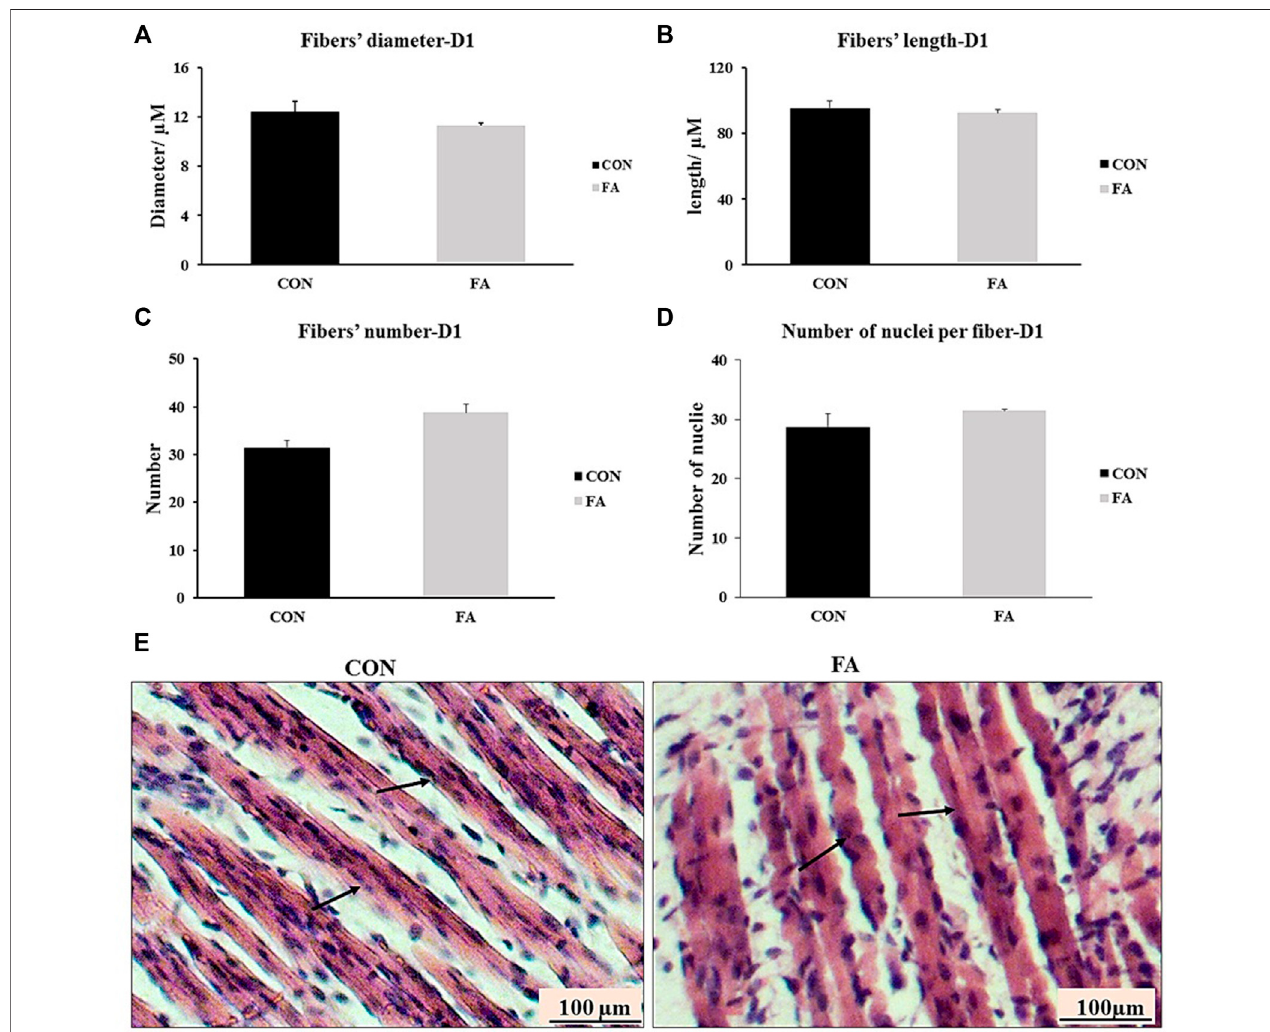
FIGURE 4| Effect of maternal intake ofEPA/DHA on myotubes formation in day 1 neonates. The mothers were fed either control diet (CON) or EPA/DHA enriched diet(FA)duringtheentireperiodofpregnancyandlactation. (A) Datashowsthedifferenceinthediameterofmuscle fi bersmeasuredinmicrometerbetweenCONandFA groups. (B) Data shows the difference in the length of muscle fi bers measured in micrometer between CON and FA groups. (C) The difference in the number of muscle fi bers inthe cross-sectionsbetweenCONand FA groups. Images wereanalyzed inImageJ-FIJI using the Freehand SelectionTool to encircle individual myo fi bers. (D) The difference in the number of nuclei per muscle fi ber between CON and FA groups. The data represent as mean ± SEM. p < 0.05 ( n = 8); eight samples per group wereusedinthismeasurementwherethevalueofeachsamplesrepresents theaverageofthemeasurementsofeight crosssectionareasrandomlyselectedfromeach sample (E) a representative microscopic image of muscle tissue stained with H&E from differentially treated groups. The magni fi cation is ×10 and scale bar is 100 μ m black arrows refer to muscle fi bers. Non-signi fi cant difference was observed between groups.